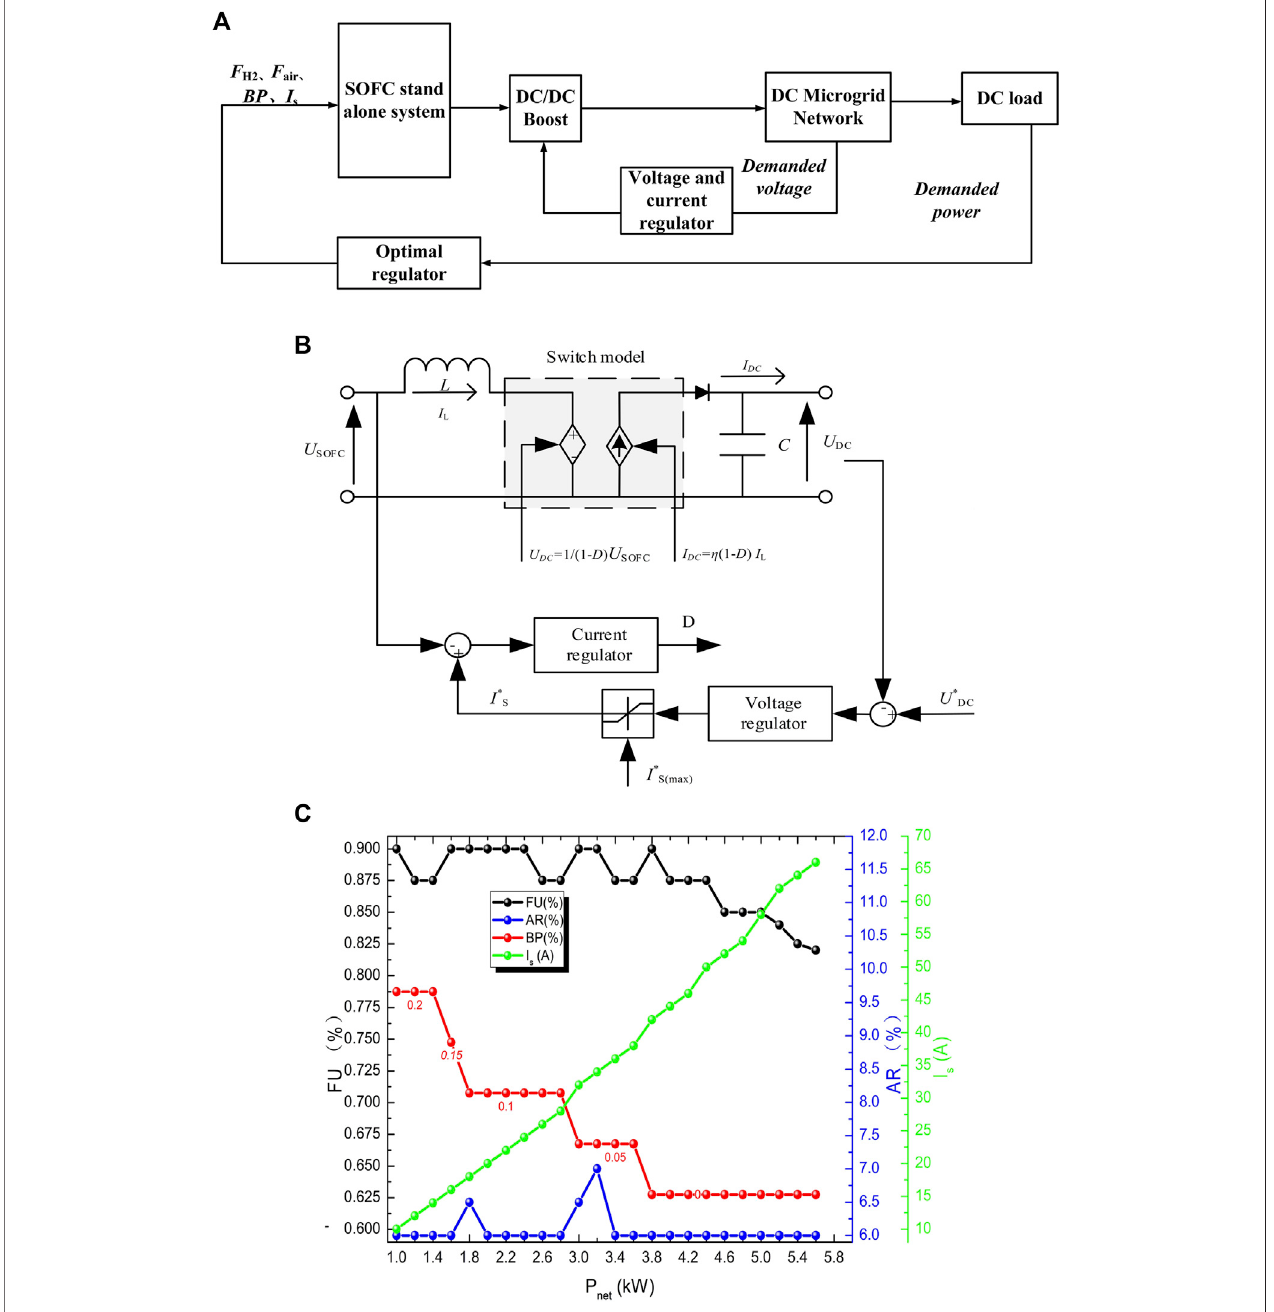
FIGURE5| ControlandoptimizationoftheSOFCDCmicrogrid. (A) Overallcontrolschemes; (B) boost-typeDC/DCconvertermodel;and (C) steady-stateoptimal points for the optimal regulator.